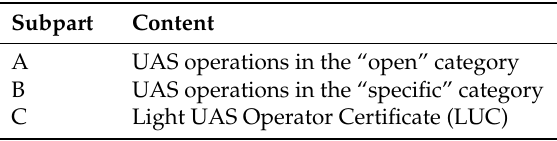
Table 3. Content of the Part UAS